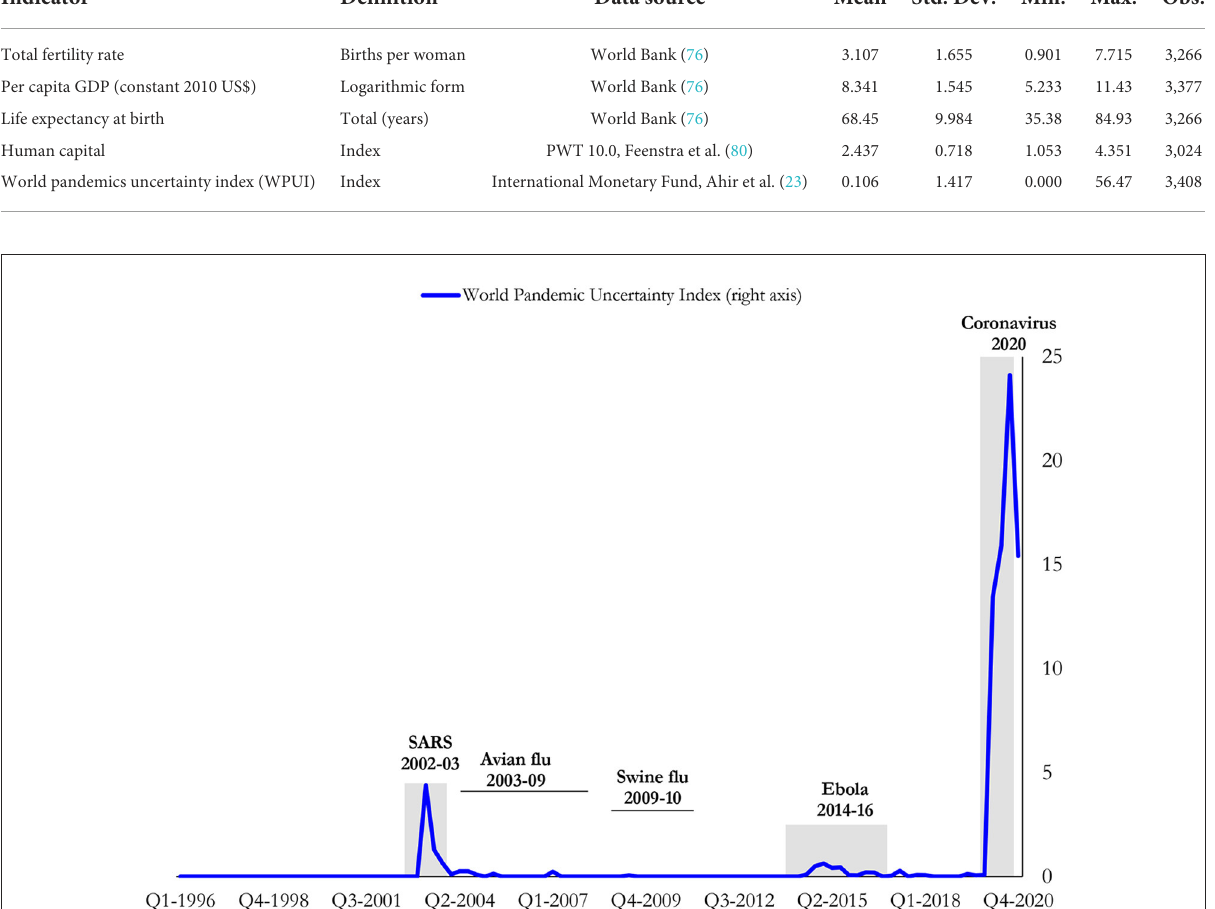
FIGURE1 World pandemics uncertainty index (WPUI) (1996–2021). Data Source: https://worlduncertaintyindex.com/data/, provided by Ahir et al. (23).